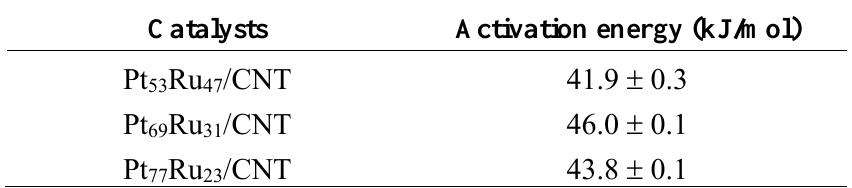
Table 3. Activation energy of the PtRu/CNT catalysts in methanol